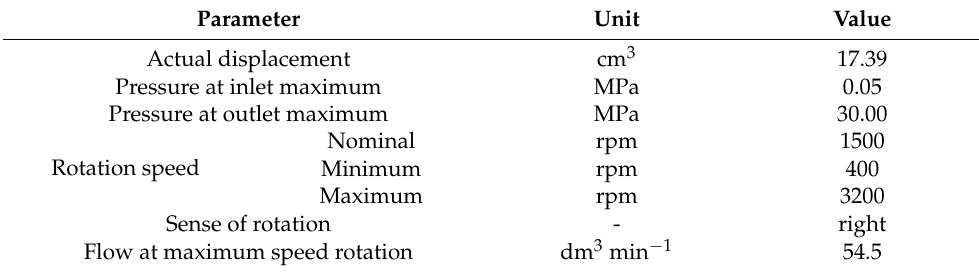
Table 1. Hydraulic gear pump GHD1-17R-S2D1-SG05G04-N.